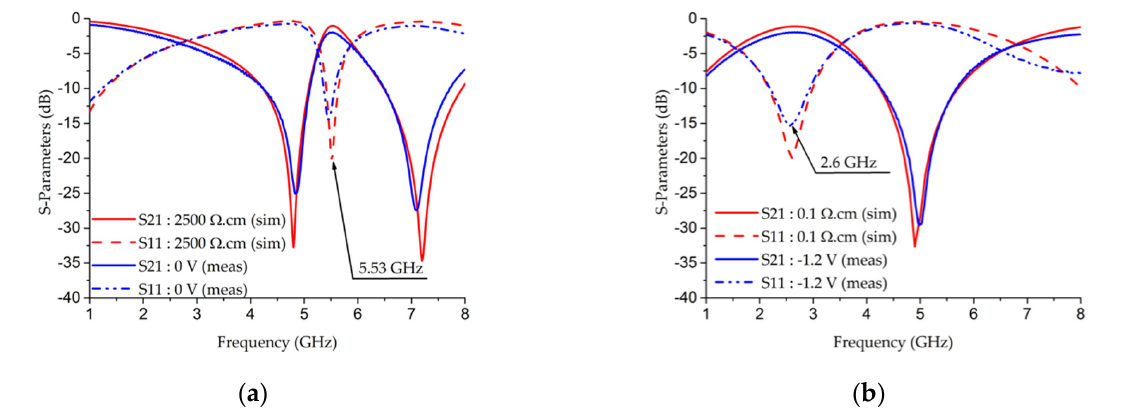
Figure 10. Comparison of simulated and measured results of switchable DBR 2 . ( a ) in the OFF state; ( b ) in the ON state.